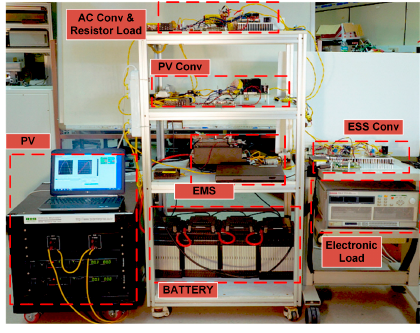
Figure 10. Experimental setup.